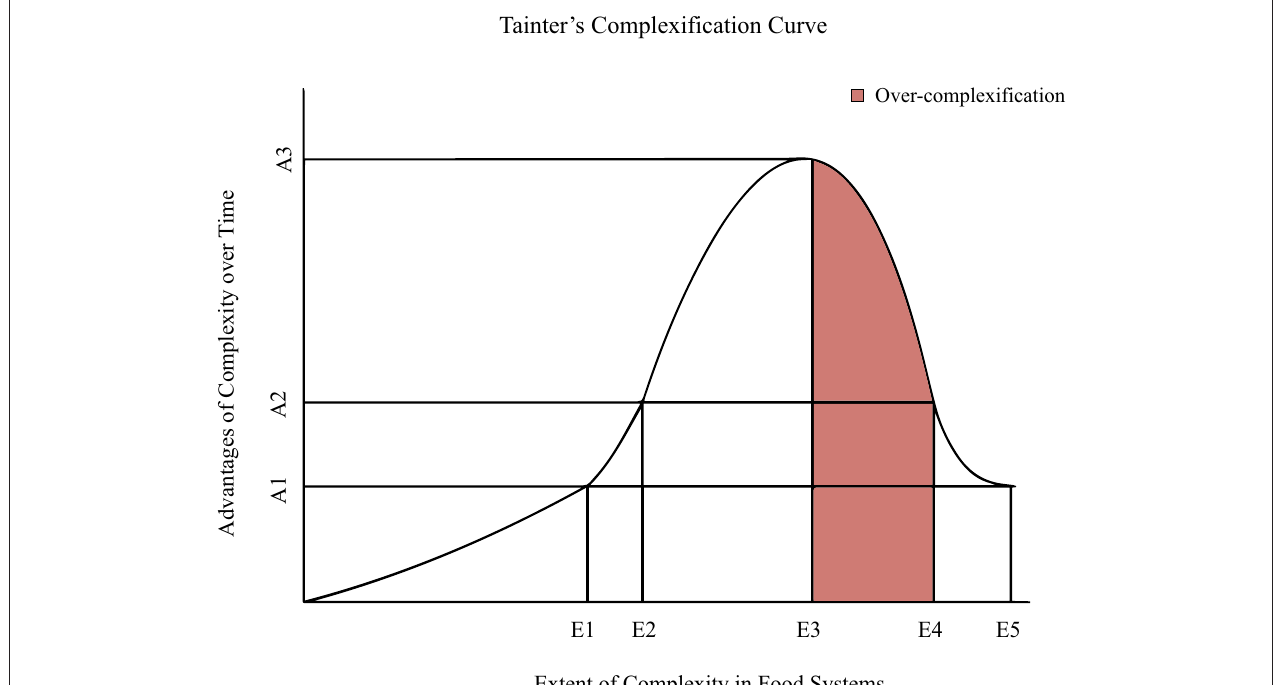
FIGURE 2 | Tainter’s theoretical relationship between complexification and efficiency. Some complexification in society is adaptive, e.g., technological innovations (A1,E1) which favorably impact the relationship between inputs and outputs (ROI). However, there is a threshold (A2,E2) at which the introduction of new technologies, while still beneficial to overall productive output, begin to have less benefit. Eventually, a threshold of over-complexification is reached (A3,E3), beyond which (shaded area) new investments in complexity are more costly than they are worth, and as such, can only be sustained by external subsidies. Historically, this is the point at which past societies have started on the pathway to collapse. If corrective action is taken (A2,E4), the relationship between complexity and energy can be stabilized to balance costs and advantages (A1,E5). Adapted from Tainter